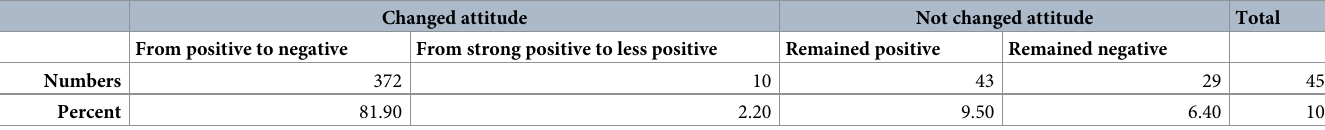
Table 1. The change in feelings towards elephants expressed by the respondents.